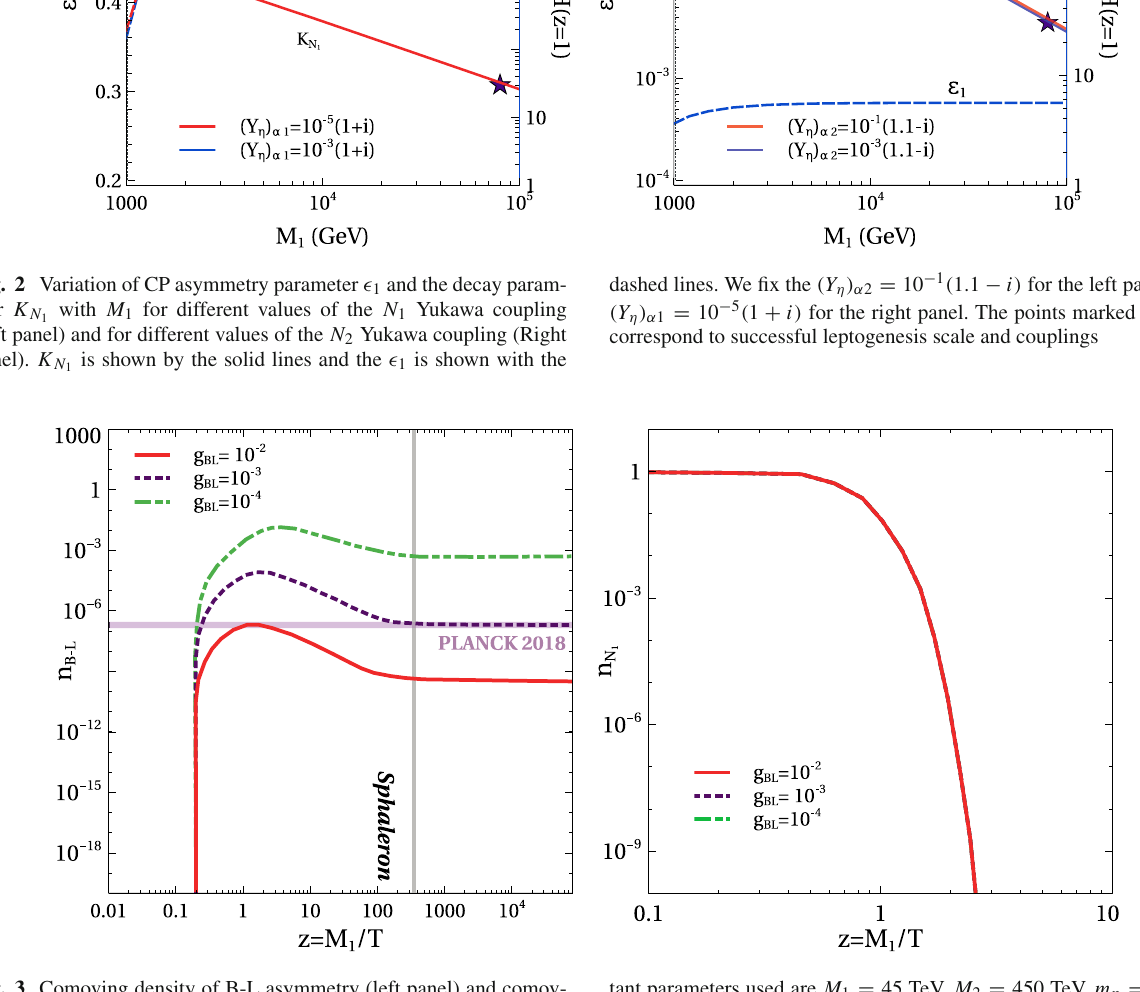
Fig. 3 Comoving density of B-L asymmetry (left panel) and comov- tant parameters used are M 1 = 45 TeV, M 2 = 450 TeV, m η = 5 TeV = 4 GeV. The horizontal line in left panel plot denotes the M 1 and M Z (right panel) with z = ing number density of N R for different BL 1 required B − L asymmetry to generate for observed baryon asymmetry T g BL . The Yukawa couplings relevant for Leptogenesis are taken to be (Planck 2018) after sphaleron ( Y η ) α = 10 − 5 ( 1 + i ) and ( Y η ) α = 10 − 1 ( 1 . 1 − i ) . The other impor- 1 2